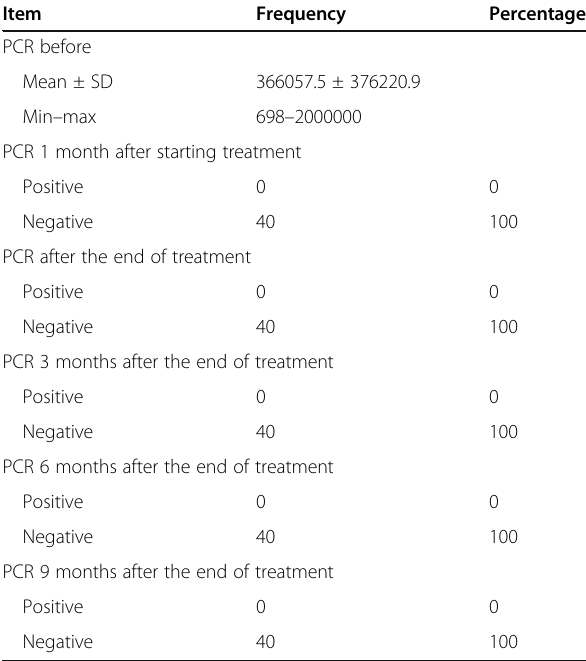
Table 4 Fibroscan of the patients at